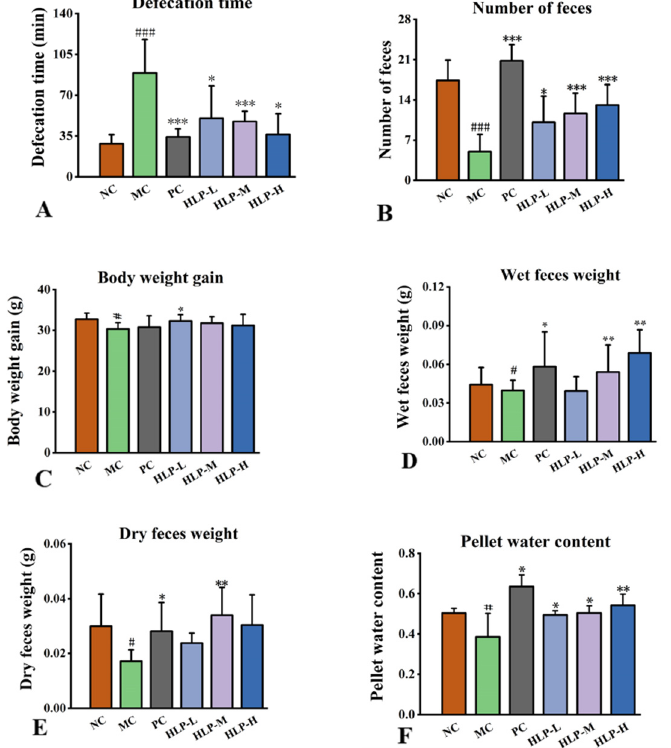
Figure 1. The effects of HLP on the parameters related to defecation in mice. ( A ) Defecation time. ( B ) Number of feces. ( C ) Body weight gain. ( D ) Wet feces weight. ( E ) Dry feces weight. ( F ) Pellet water content. # p < 0.05, ### p < 0.001 vs. NC group; * p < 0.05, ** p < 0.01, *** p < 0.001 vs. MC group. NC: normal control group, MC: model control group, PC: positive control group, HLP-L: low-dosage HLP group, HLP-M: middle-dosage HLP group, and HLP-H: high-dosage HLP group.